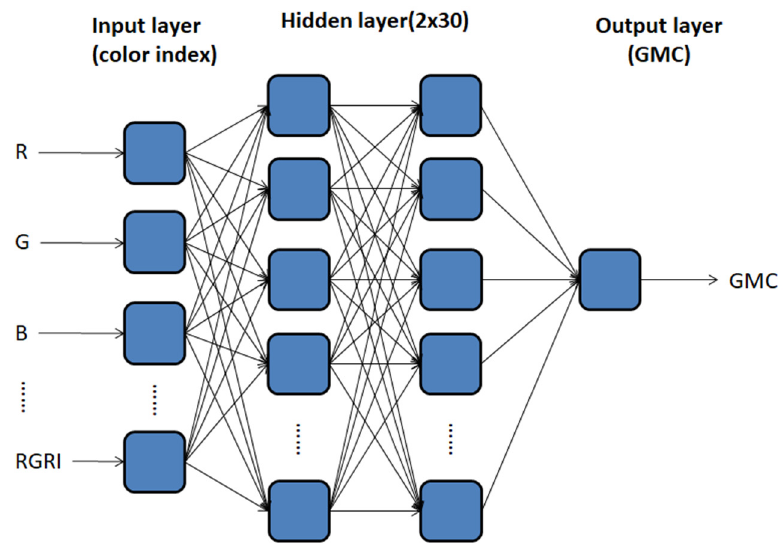
Figure 10. MLP structure of Image-GMC assessment